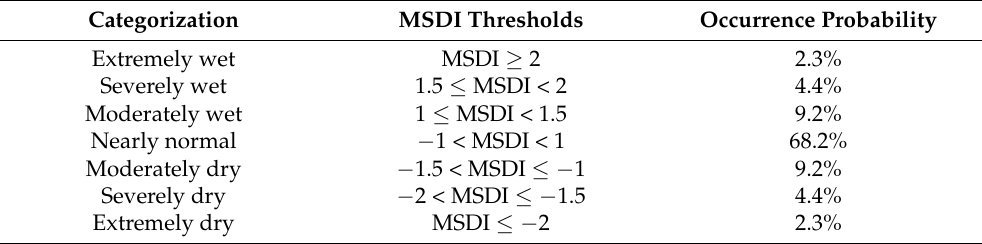
Table 1. The categorization of dry and wet conditions based on the MSDI